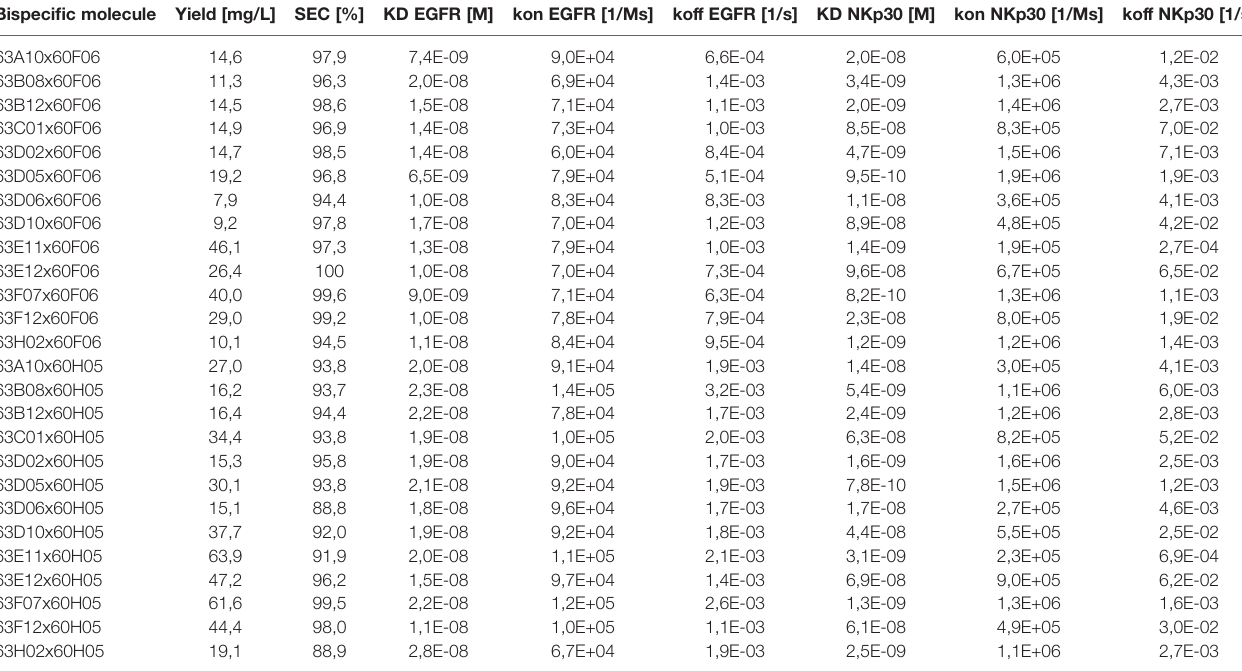
TABLE 1 | Biophysical and biochemical characterization of cattle-derived ultralong CDR-H3 common light chain bispeci fi c